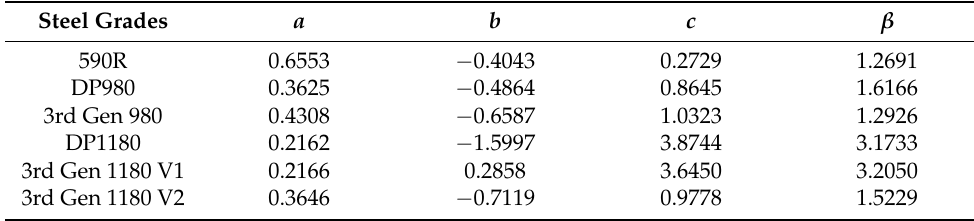
Table 9. Calibration coefficients for the GDP fracture loci for the studied steel grades. Steel